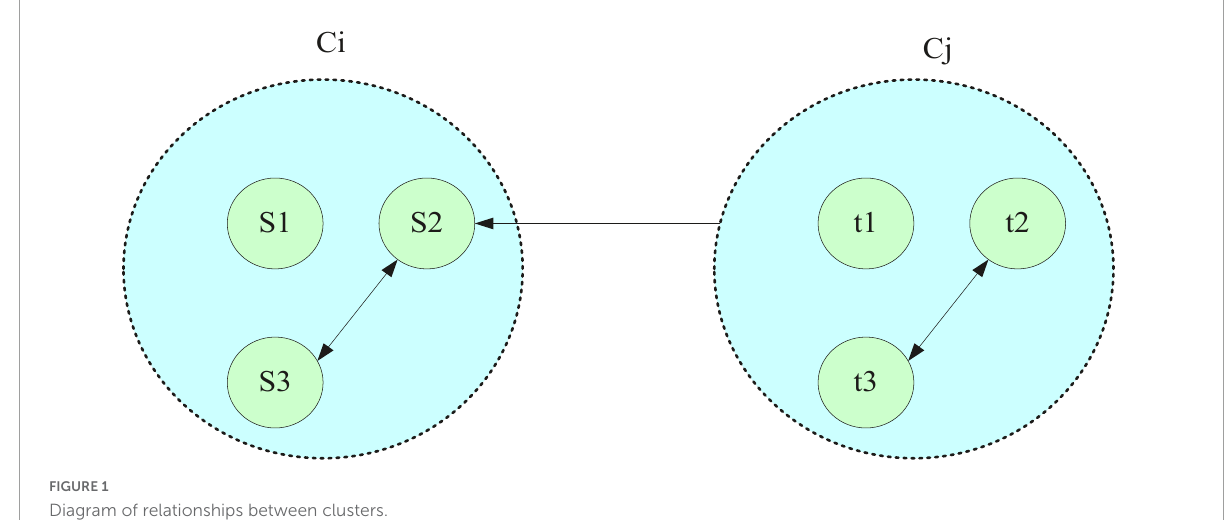
FIGURE1 Diagram of relationships between clusters.